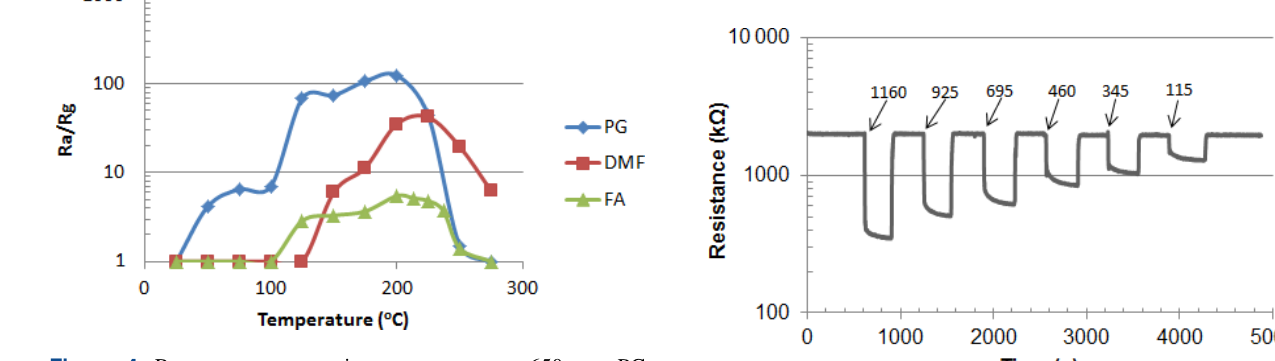
Figure 4. Response vs. operating temperature at 650ppm PG, 500ppm DMF and 1160ppm FA vapor exposure.